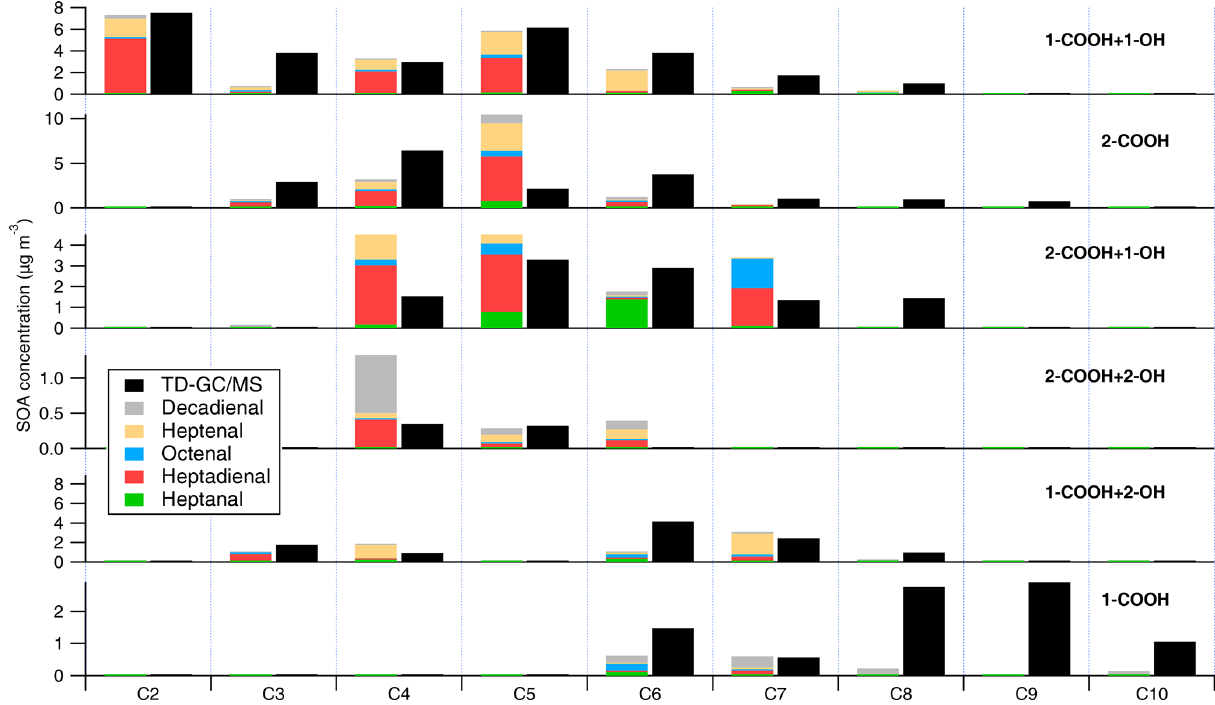
Figure 6. Prediction of different compounds formed at an OH exposure of 6 . 43 × 10 10 moleculescm − 3 s using product molar yields of heptanal, heptenal, octenal, heptadienal, and decadienal. The total aldehyde products can explain the observed oil SOA products within a factor of 0.5, while the inconsistency in prediction of some SOA products is likely caused by differences in gas-particle partitioning in both photooxidation